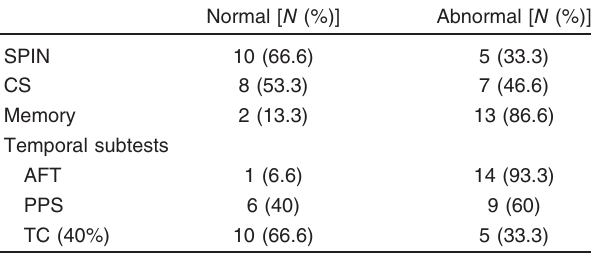
Table 2 Distribution of central auditory tests ’ abnormality